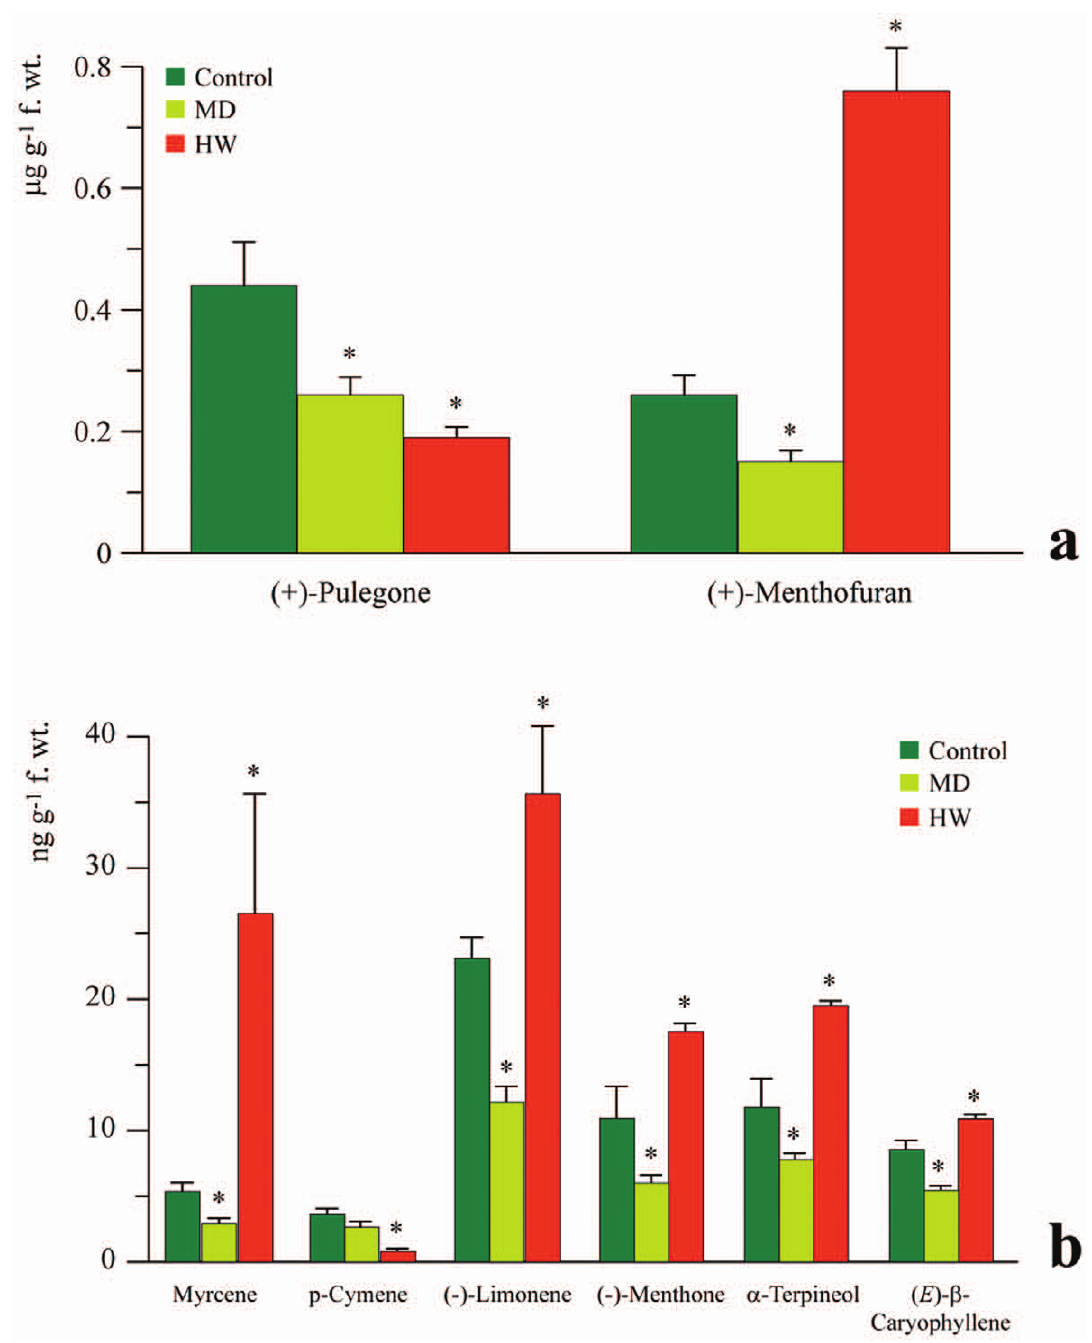
Figure 2. VOC emission by M.aquatica in undamaged plants (control), in response to mechanical damage caused by a pattern wheel (MD) and after herbivory by C.herbacea (HW). a , Content of the major components; b , content of the minor components. Bars indicate the standard error over the mean of at least three biological replicates. Asterisks indicate significant differences with respect to controls (P , 0.05). doi:10.1371/journal.pone.0017195.g002 the operationally soluble, NAD-dependent isopiperitenol dehy- GPP to the parent olefin ( 2 )-limonene, showed the same trend as Ippi , being up-regulated by herbivory and down-regulated by drogenase that catalyzes allylic oxidation to the a , b -unsaturated ketone ( 2 )-isopiperitenone, Ipr , which codes the soluble enzyme mechanical damage (Fig. 5). Several genes were always up- ( 2 )-isopiperitenone reductase that catalyzes the stereospecific, regulated by herbivory and showed no regulation after mechanical NADPH-dependent reduction of ( 2 )-isopiperitenone to ( + )- damage (Fig. 5). The genes included L3oh , which codes for the (1R,4R)-cis-isopulegone, and Mfs , which codes for menthofuran enzyme responsible for the NADPH- and O 2 -dependent hydrox- synthase, an enzyme responsible for the transformation of ( + )- ylation of ( 2 )-limonene to ( 2 )- trans -isopiperitenol, Ipd , which codes